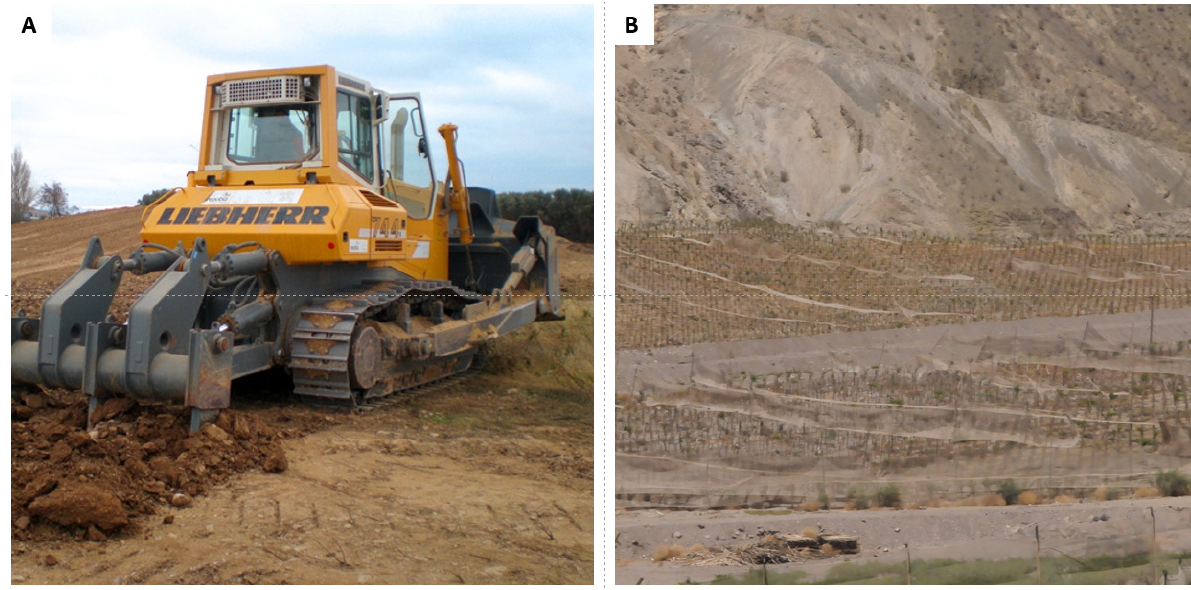
Figure 1. Soil preparation in the study area: ( A ) (left) shows intensive processes with agricultural machinery; ( B ) (right) shows soil preparation performed processes performed by small farmers. Sources: ( A ) available in https://www.goharvest.cl/movimientos-de-tierra/ (accessed on 29 October 2022), ( B ) authors’ own